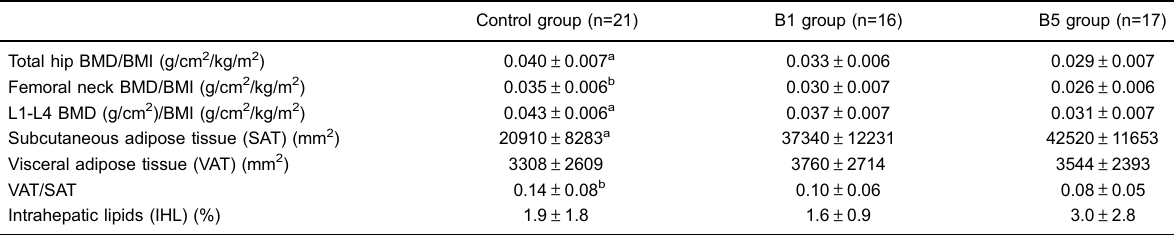
Table 2. Dual-energy X-ray absorptiometry and magnetic resonance results of the control group, and obese women evaluated one year (B1) and fi ve (B5) years after Roux-en-Y gastric bypass.